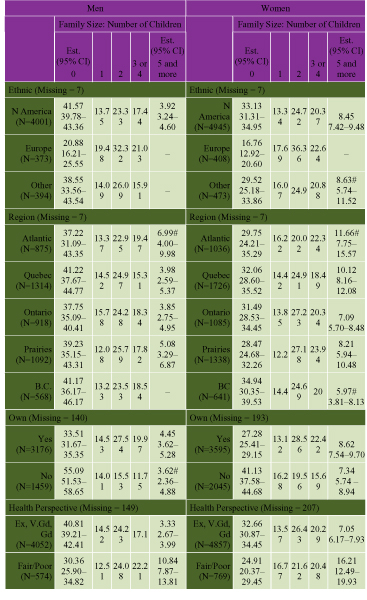
Showing the Sex Specific Distribution of Family Size by Ethnicity, Region, Home Ownership and Perspective of Health Data Source: GSS Cycle 10, 1995